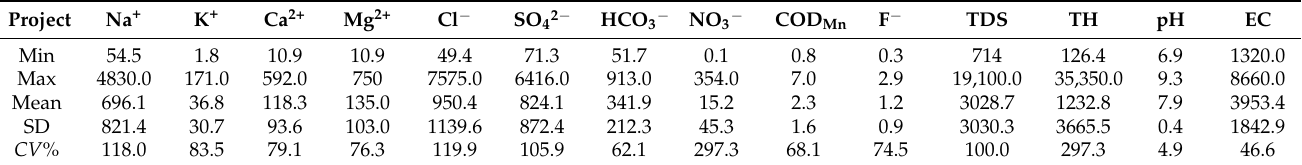
Table 2. Statistical results of main hydrochemical parameters of